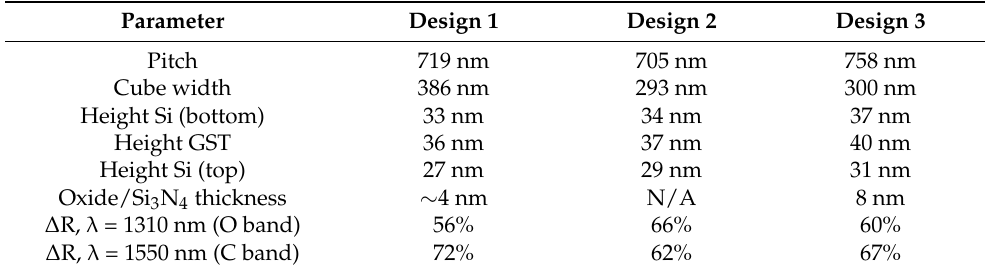
Table 1. Optimized device dimensions and modulation depth of three considered designs.